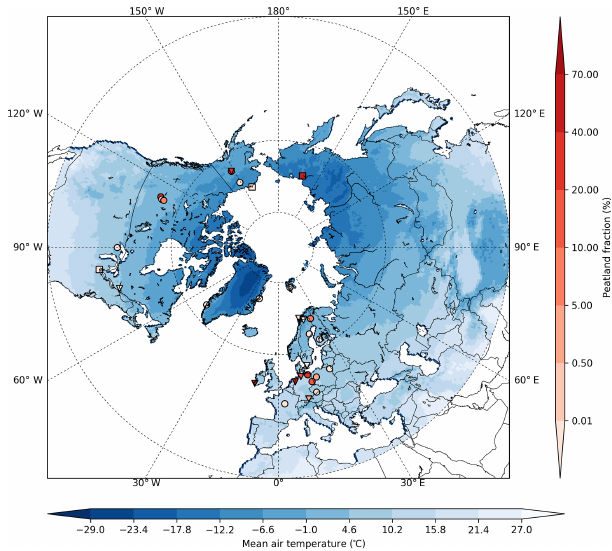
Figure 2. The distribution of 30 peatland sites used in this study. Triangles are bogs; circles are fens; squares are tundra and marsh. Colors of the markers indicate peatland fractions in the 0.5 ◦ grid cell. Mean air temperatures is the annual mean from 1999 to 2015, based on the 6-hourly CRU-NCEP 0.5 ◦ global